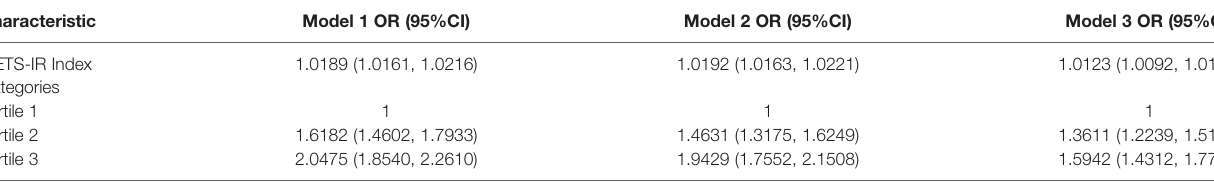
TABLE 2 | Analysis between METS-IR index with kidney stone formation.